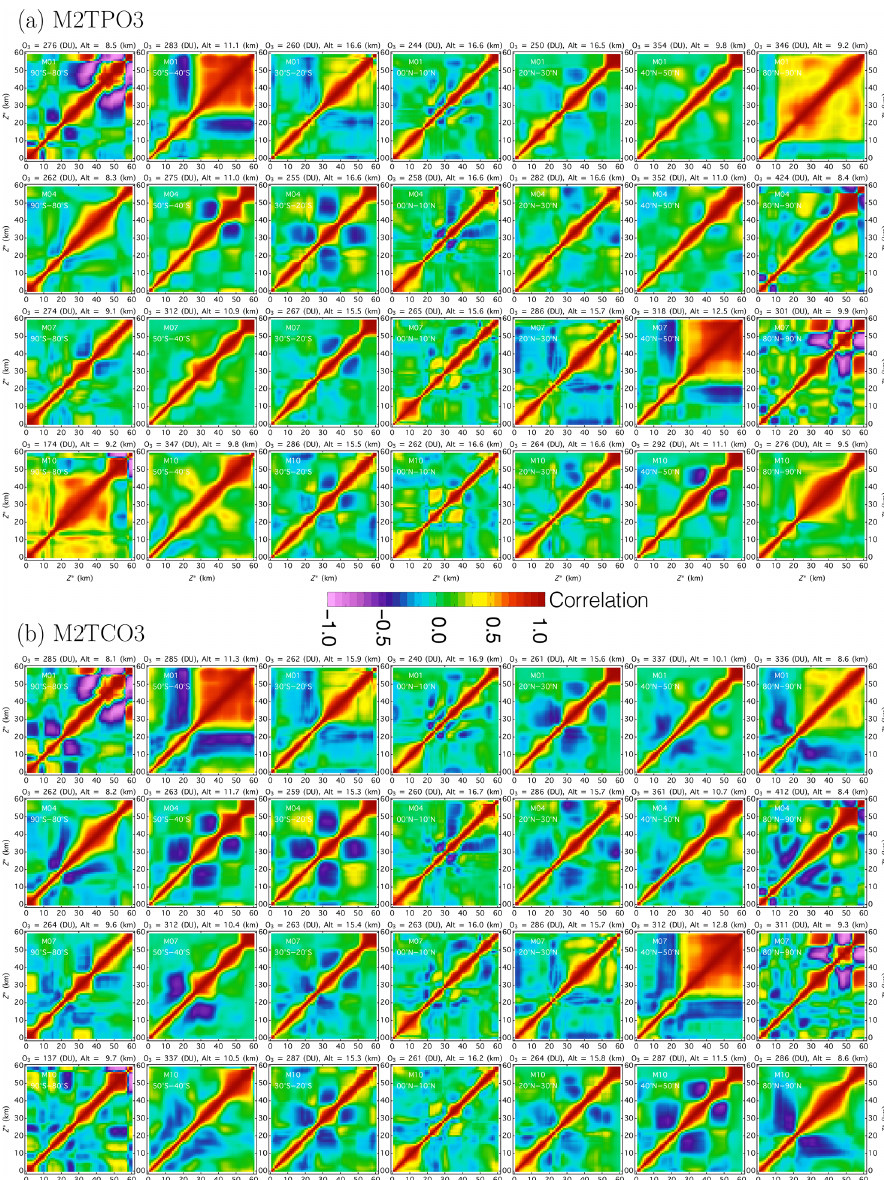
Figure 8. Correlation matrices from M2TPO3 (a) and M2TCO3 (b) for four months and seven latitude zones (same as those in Fig. 4). Here the matrix for the highest-occurrence climatological profile is shown for each month–latitude class.